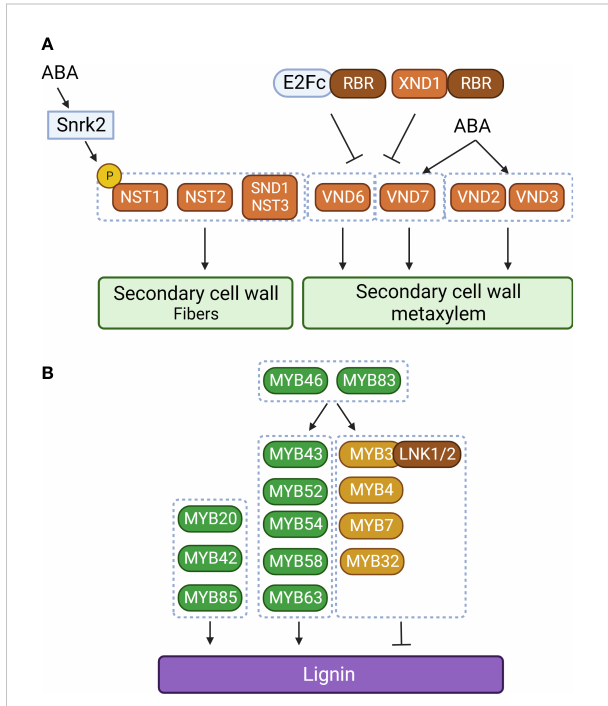
FIGURE 2 The NAC – MYC transcriptional network of lignin biosynthetic genes in plants. (A) Regulation of secondary cell wall development in xylem cells and fi bers. ABA regulates xylem cell and fi ber development through phosphorylation of NAC SECONDARY WALL THICKENING PROMOTING FACTOR1 (NST1) and transcriptional activation of VASCULAR-RELATED NAC DOMAIN 2 (VND2), VND3, and VDN7. SnrK2, SNF1-related protein kinase 2; RBR, RETINOBLASTOMA-RELATED; XND1, XYLEM NAC DOMAIN 1. (B) Transcriptional regulation of lignin biosynthesis. LNK1, NIGHT LIGHT-INDUCIBLE AND CLOCK-REGULATED 1; Orange box, NAC transcription factor; green and light brown boxes, MYB transcription factor; dark brown box, transcriptional corepressor; black arrow, activation; black line with bar, repression. The fi gure was created with Biorender